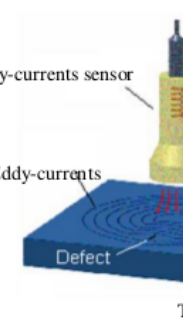
Figure 5: Image of Eddy current